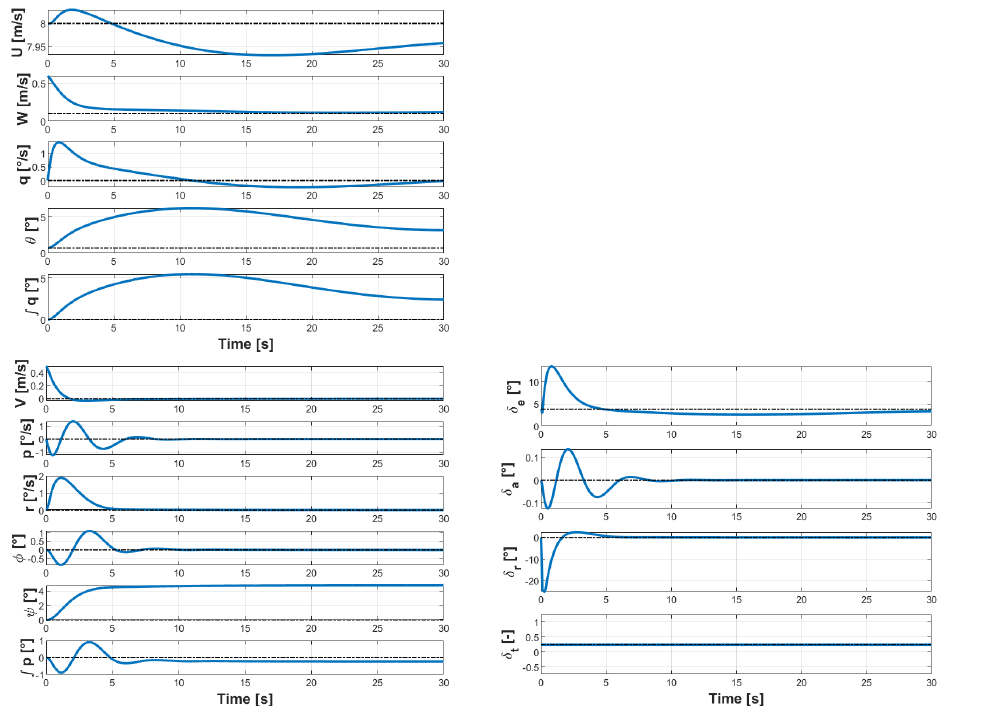
Figure 9. Time response of baseline airship with stabilizing control, in trimmed horizontal flight at a ground speed of 8 m/s, to an initial perturbation of ∆ W = ∆ V = 0.5 m/s. ( Top-left ) and ( bottom-left ) longitudinal and lateral-directional states. ( Bottom-right ) controls. Black dash-dotted lines: trimmed value.